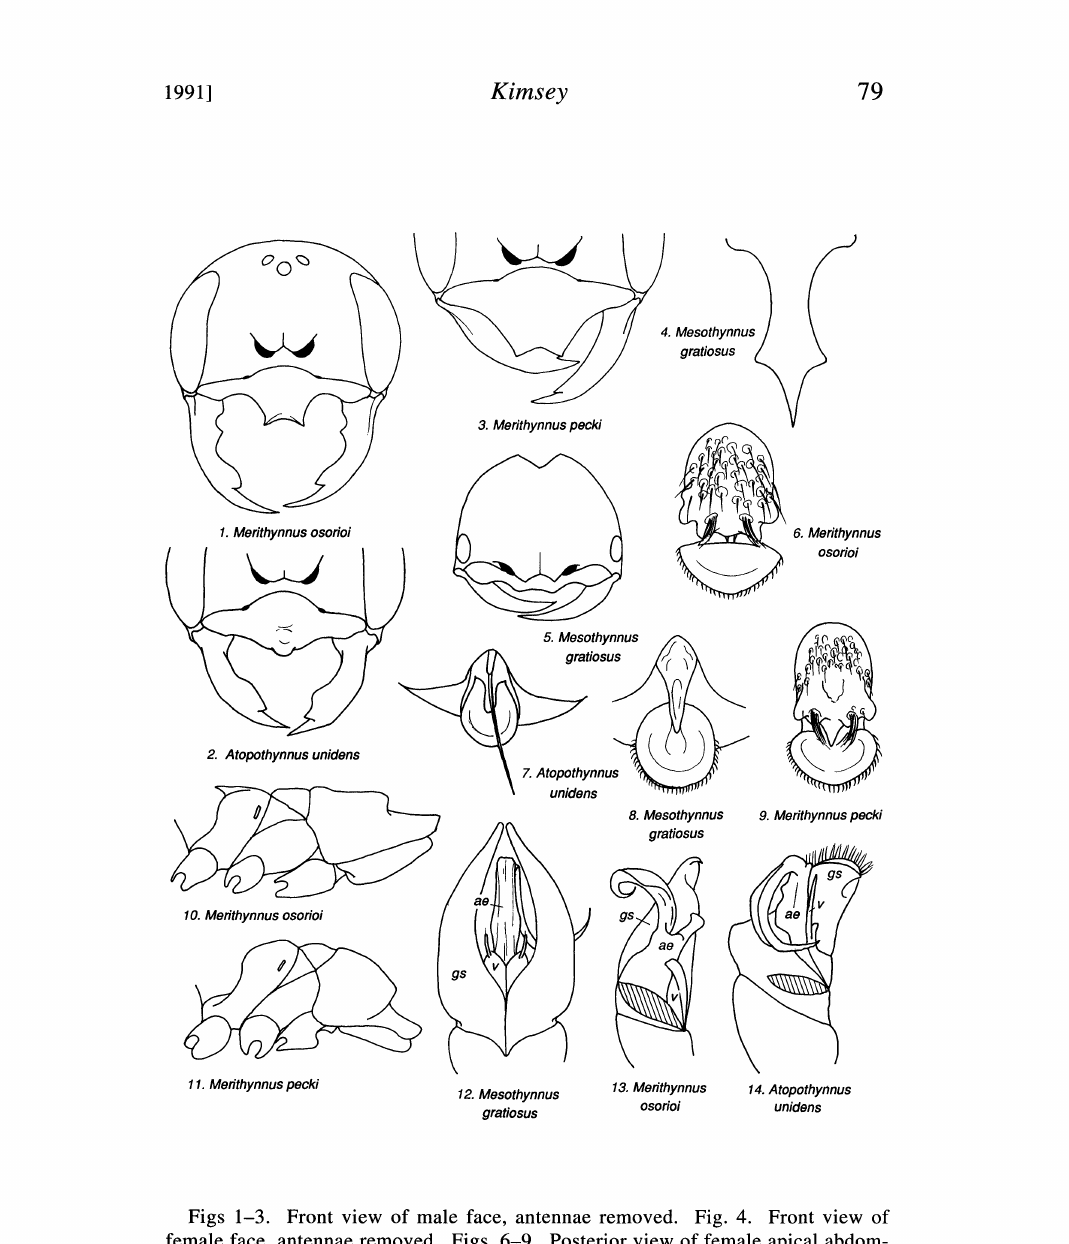
Figs 1-3. Front view of male face, antennae removed. Fig. 4. Front view of female face, antennae removed. Figs. 6-9. Posterior view of female apical abdom- inal tergum (dorsal) and sternum (ventral). Figs. 10-11. Lateral view of female thorax. Figs. 12-14. Male genital capsule: